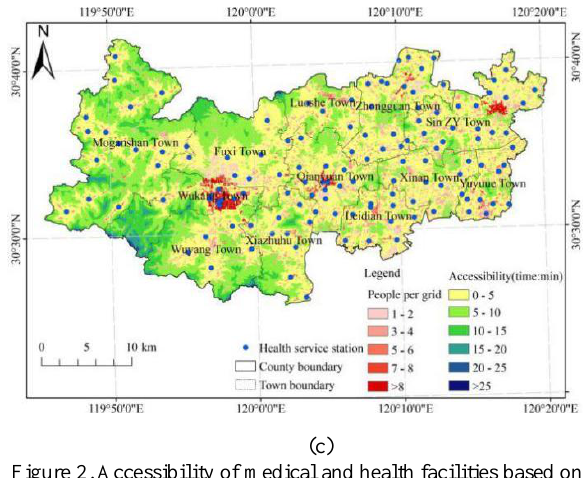
Figure 2. Accessibility of medical and health facilities based on 30m grid population density in Deqing County. (a) Accessibility of general hospitals; (b) Accessibility of health centers; (c) Accessibility of health service stations.